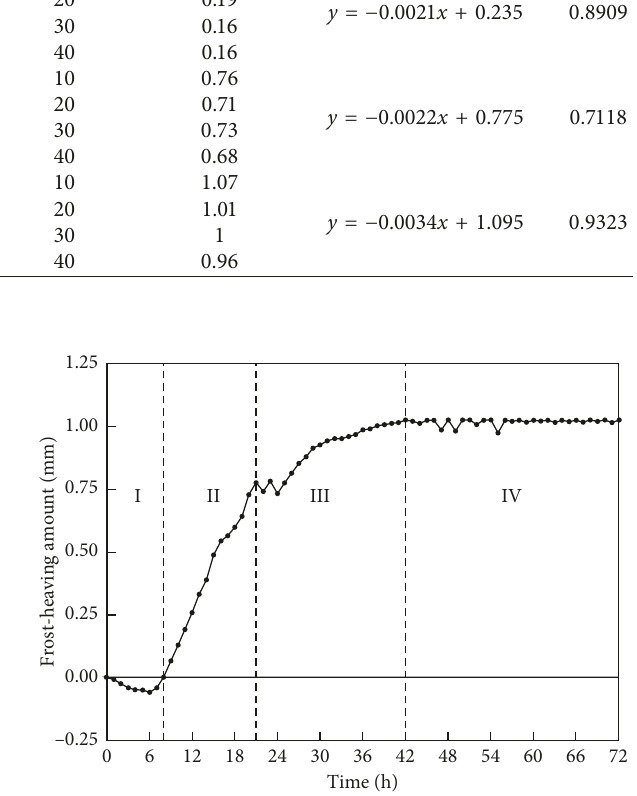
Figure 8: Variation of frost heave amount with time.